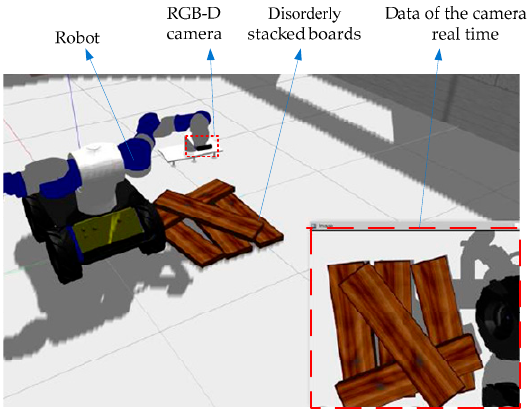
Figure 11. Visual grasping scene model of stacked wooden planks.